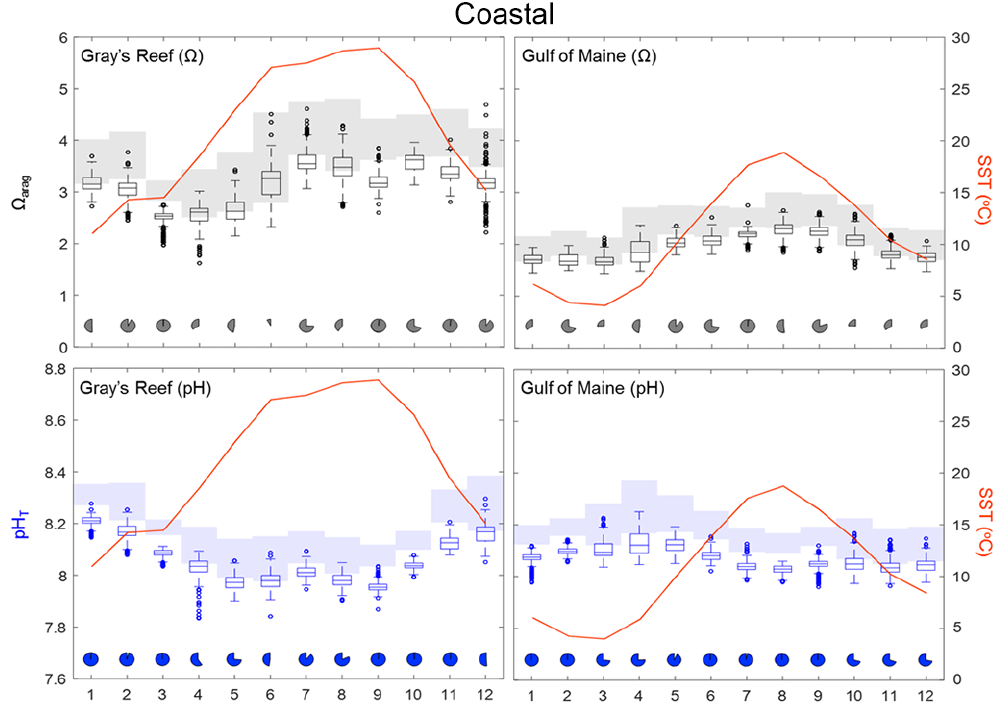
Figure 6. Box and whisker plots of present-day monthly surface seawater (cid:127) arag (top) and pH (bottom) and monthly mean SST at the coastal mooring locations on the continental shelves of the US east coast (Gulf of Maine, Gray’s Reef). See detailed description of figure components in Fig. 2